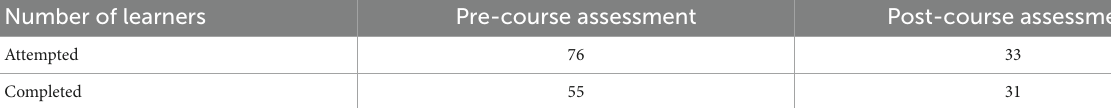
TABLE 2 Number of learners attempted and completed pre-and post-course assessment.